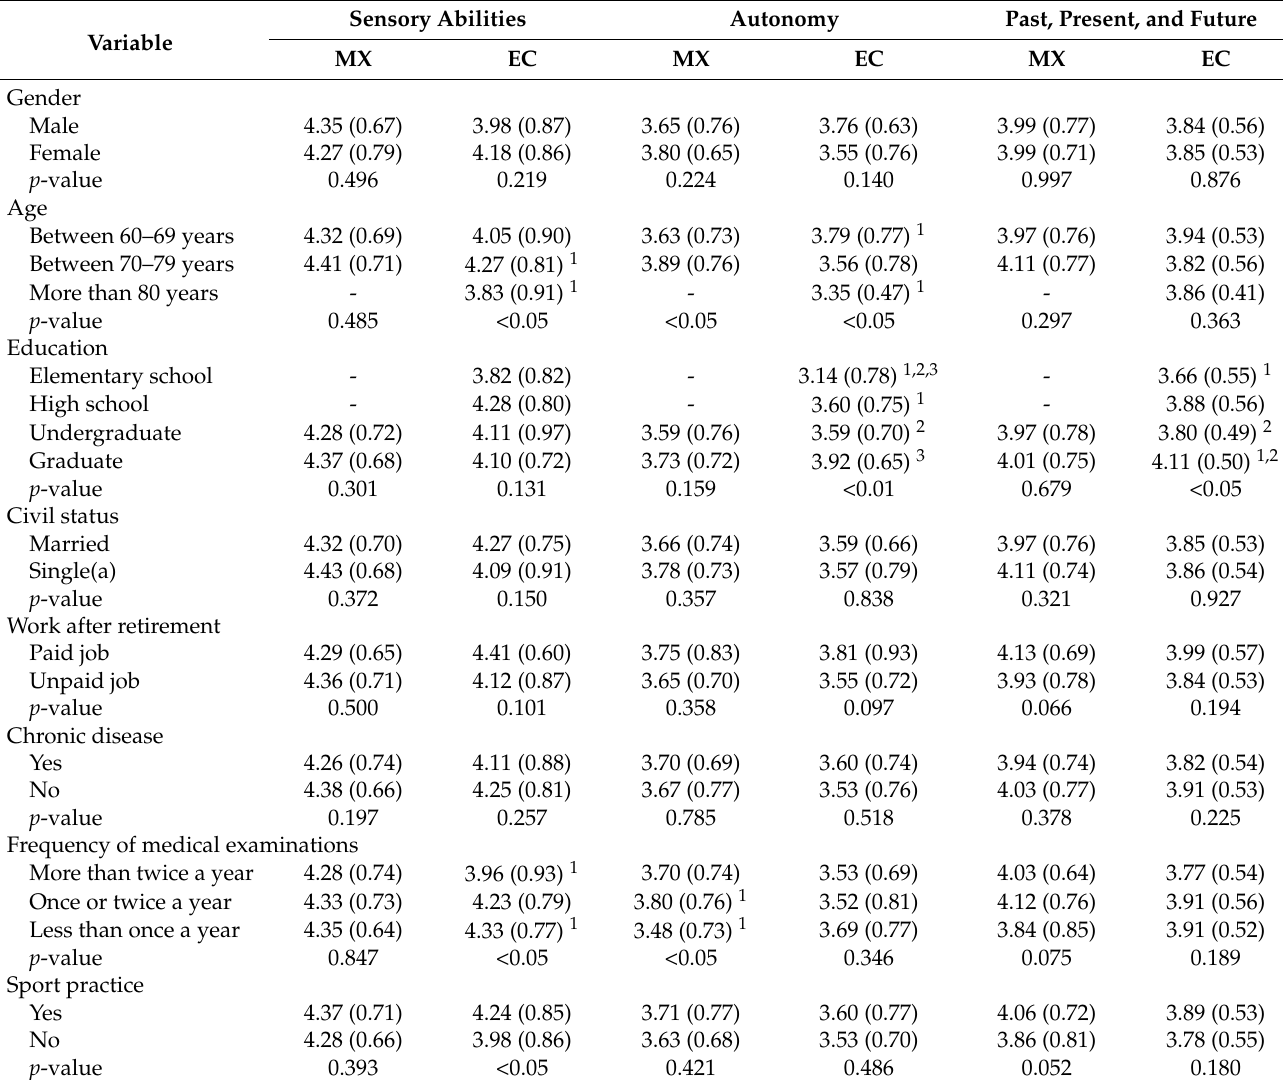
Table 2. Mean comparison of the WHOQOL-OLD dimensions among countries by sociodemographic characteristics. First